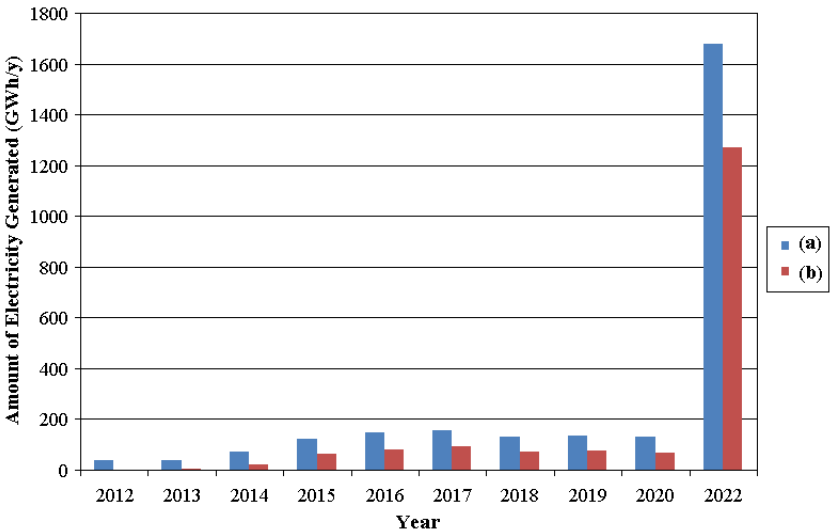
Figure 9. Actual annual amounts and projections of electricity generated by NIS [91]: ( a ) total generation of electricity, and ( b ) electricity sold.